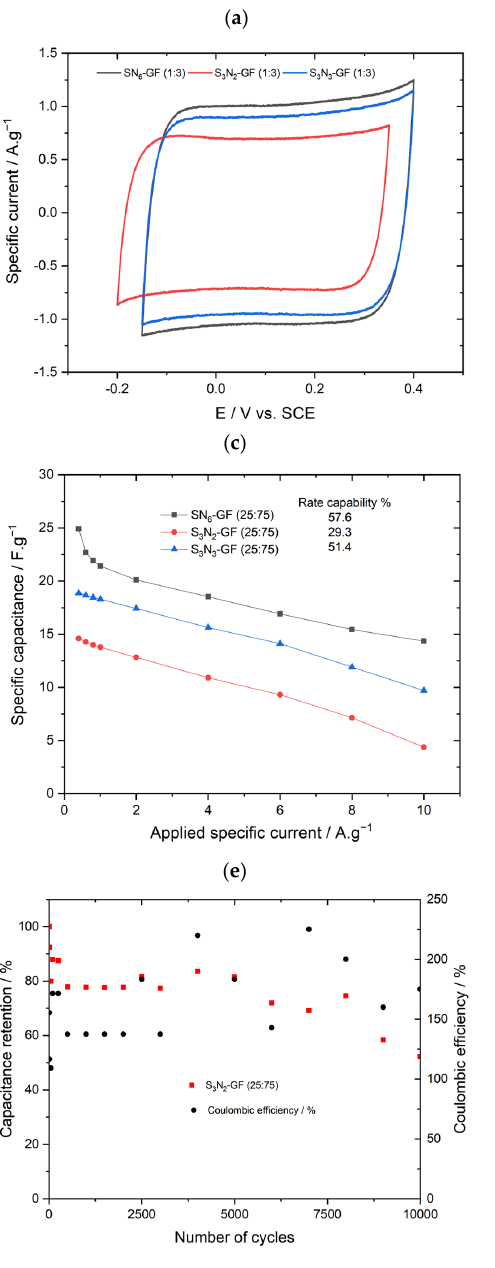
Figure 5. Electrochemical results for different dopants and different dopant ratios in 1 M KOH elec ‐ trolyte for SN 6 − GF (25:75), S 3 N 2 − GF (25:75), and S 3 N 3 − GF (25:75): ( a ) cyclic voltammetry at 50 mV ∙ s − 1 ; ( b ) discharge curves at 1.0 A ∙ g − 1 ; ( c ) specific capacitance at different applied specific current from 0.4 A ∙ g − 1 to 10.0 A ∙ g − 1 ; and capacitance retention after 10,000 cycles of charge–discharge at 10.0 A ∙ g − 1 for ( d ) SN 6 − GF (25:75), ( e ) S 3 N 2 − GF (25:75), and ( f ) S 3 N 3 − GF (25:75). Table 4. Summary of specific capacitance values obtained for the different co ‐ doped materials pre ‐ pared in this study at different applied specific currents in 1 M Na 2 SO 4 .